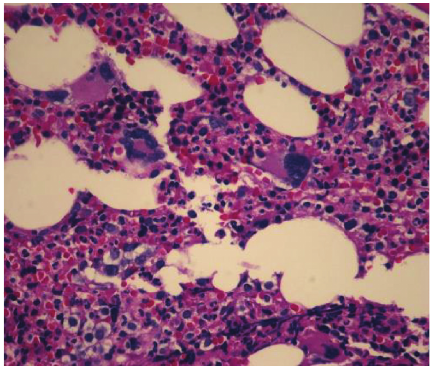
Figure 3: H&E stain of the bone marrow biopsy showing atypical